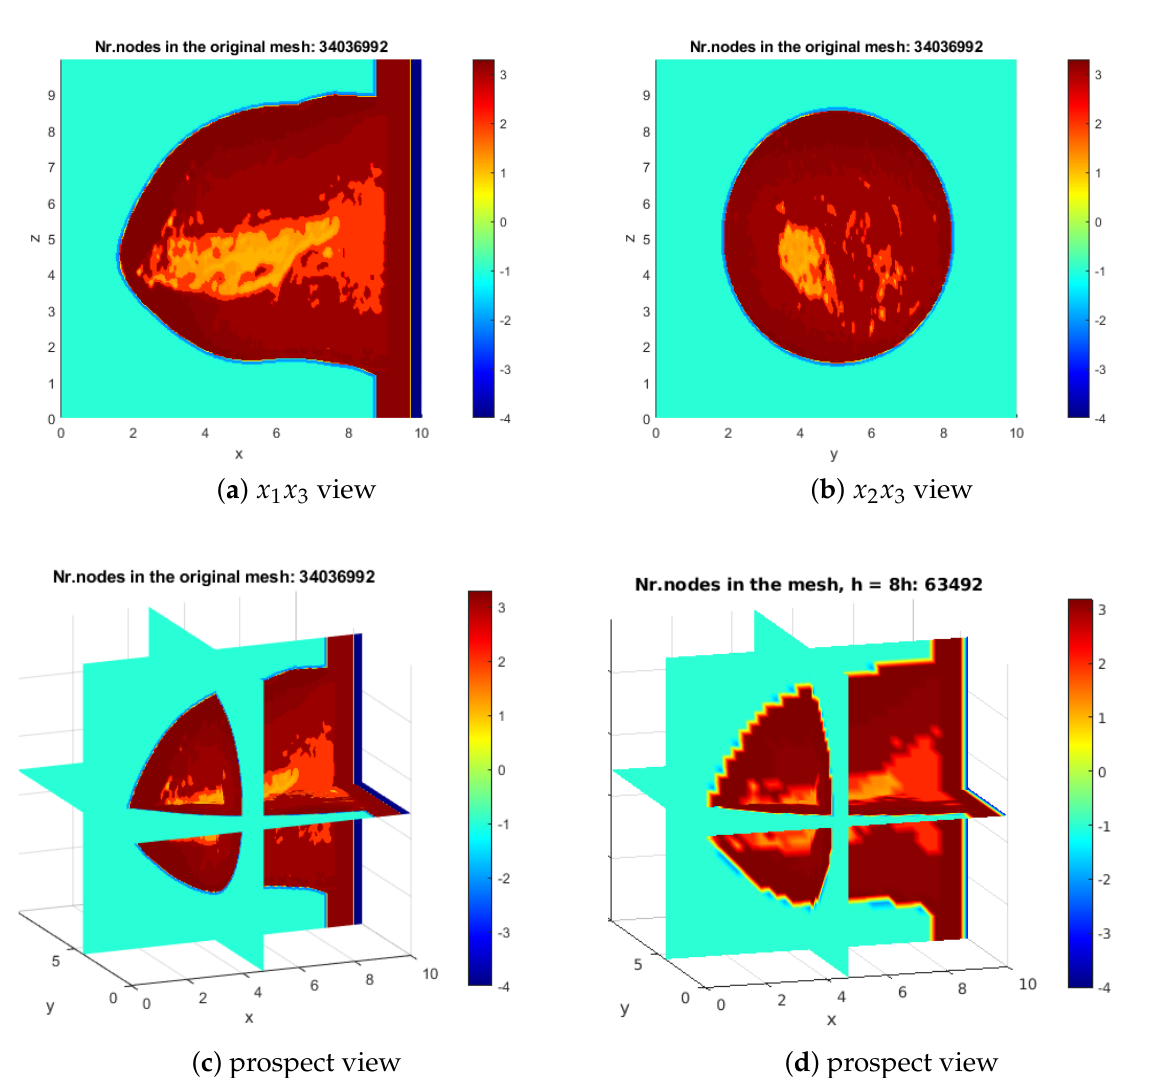
Figure 3. ( a–c ) Original values and ( d ) sampled values of the spatial distribution of media numbers